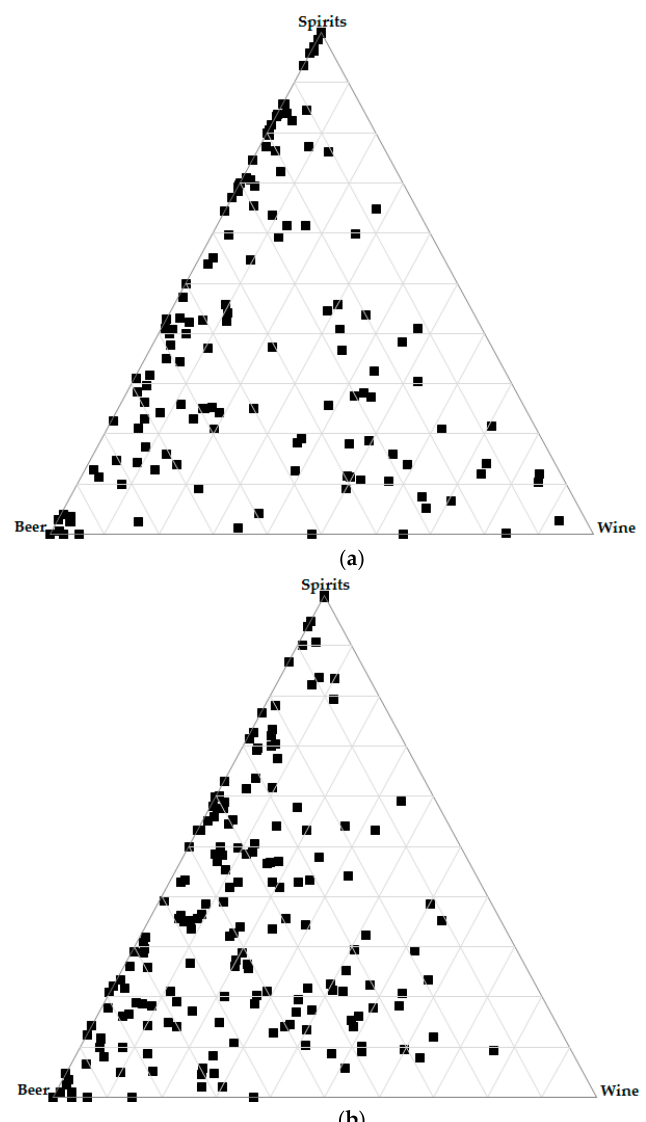
Figure 5. Tertiary plots for all the countries in the WHO database for ( a ) 1970 and ( b ) 2010. Notes: Each dot represents a particular country. Labels are omitted for the sake of the clarity of tertiary plots.